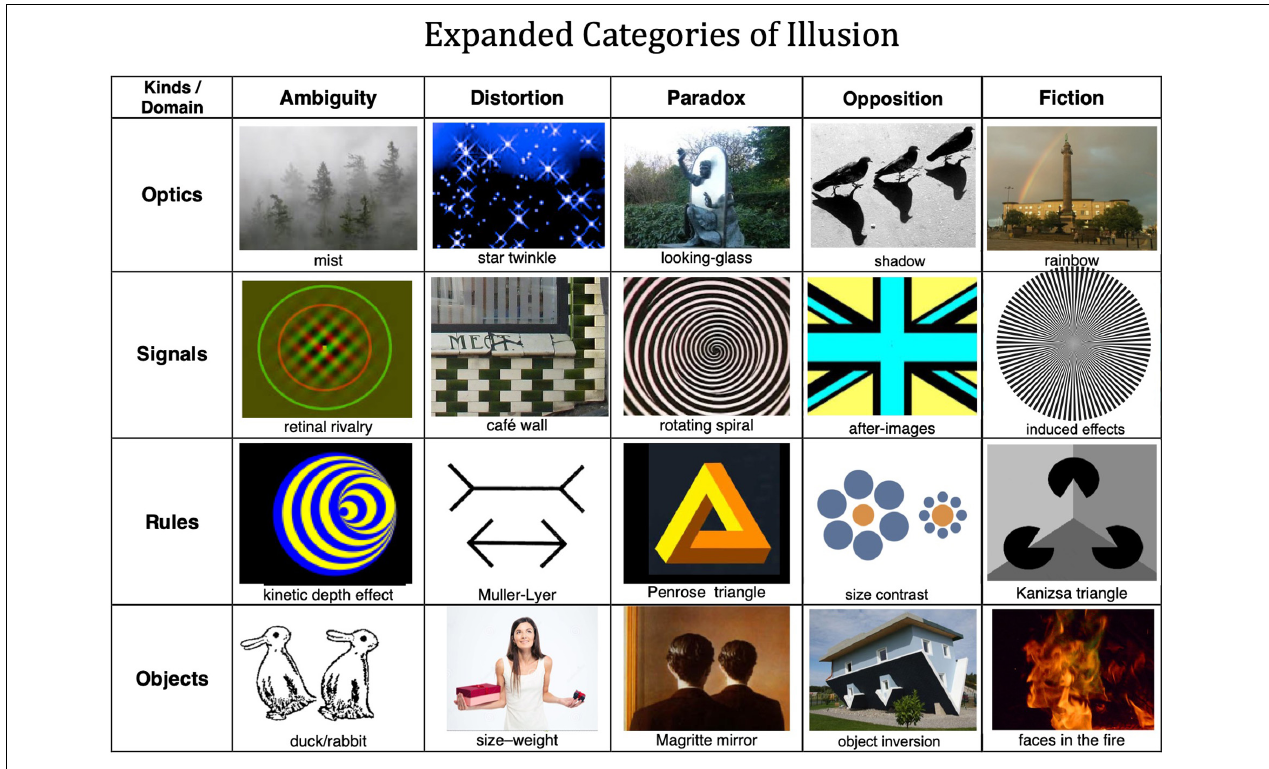
FIGURE 5 | Expanded table of illusion categories, with an illustrative example of each one, respectively of the categories of ambiguity, distortion, paradox, opposition, and fiction. Row 1—optical illusions: trees in mist, twinkling stars, Alice through the looking-glass in a Lewis Carroll memorial, shadows, rainbow in Liverpool. Row 2—signal illusions: anaglyph stimulus for binocular rivalry, the original café wall in Bristol, evocation of a motion aftereffect, flag image to evoke standard-color afterimage, induced scintillations. Row 3—rule illusions: stimulus to evoke kinetic depth when rotated, Müller-Lyer arrows, Penrose impossible triangle, Ebbinghaus size contrast illusion, ambiguous shading-enhanced version of the Kanizsa illusory triangle. Row 4—object illusions: double ambiguous duck-rabbit, depiction of the size-weight illusion, Magritte painting of a non-reversing mirror, physically inverted house, faces-in-the-flame